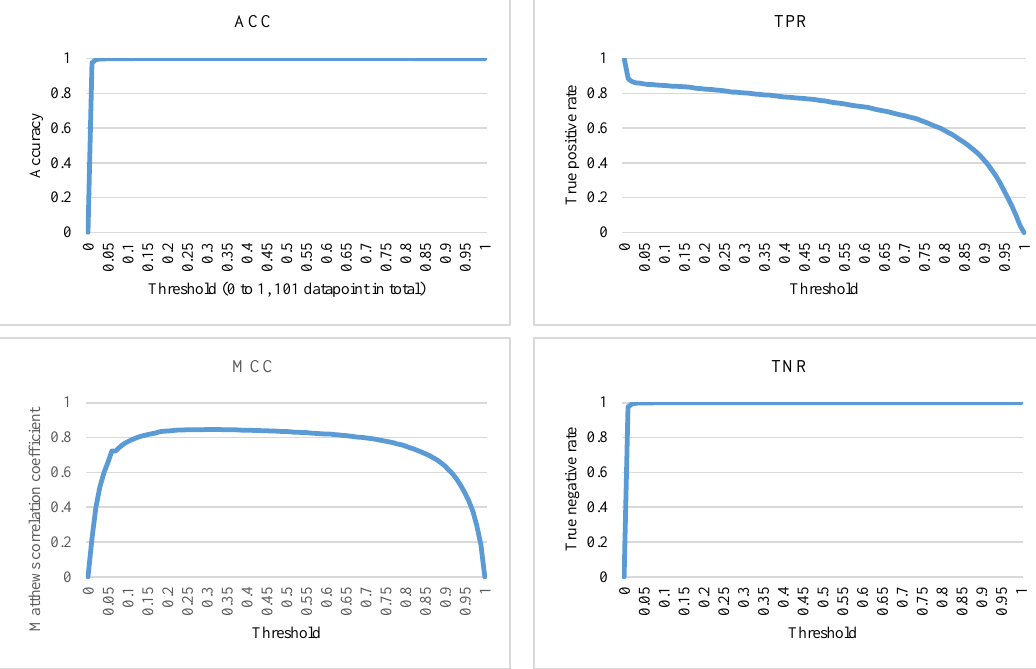
Figure 5. The zoomed-in ROC curve of AE-PRF (for FPR in [0.00, 0.05] and TPR in [0.01, 1.00]).